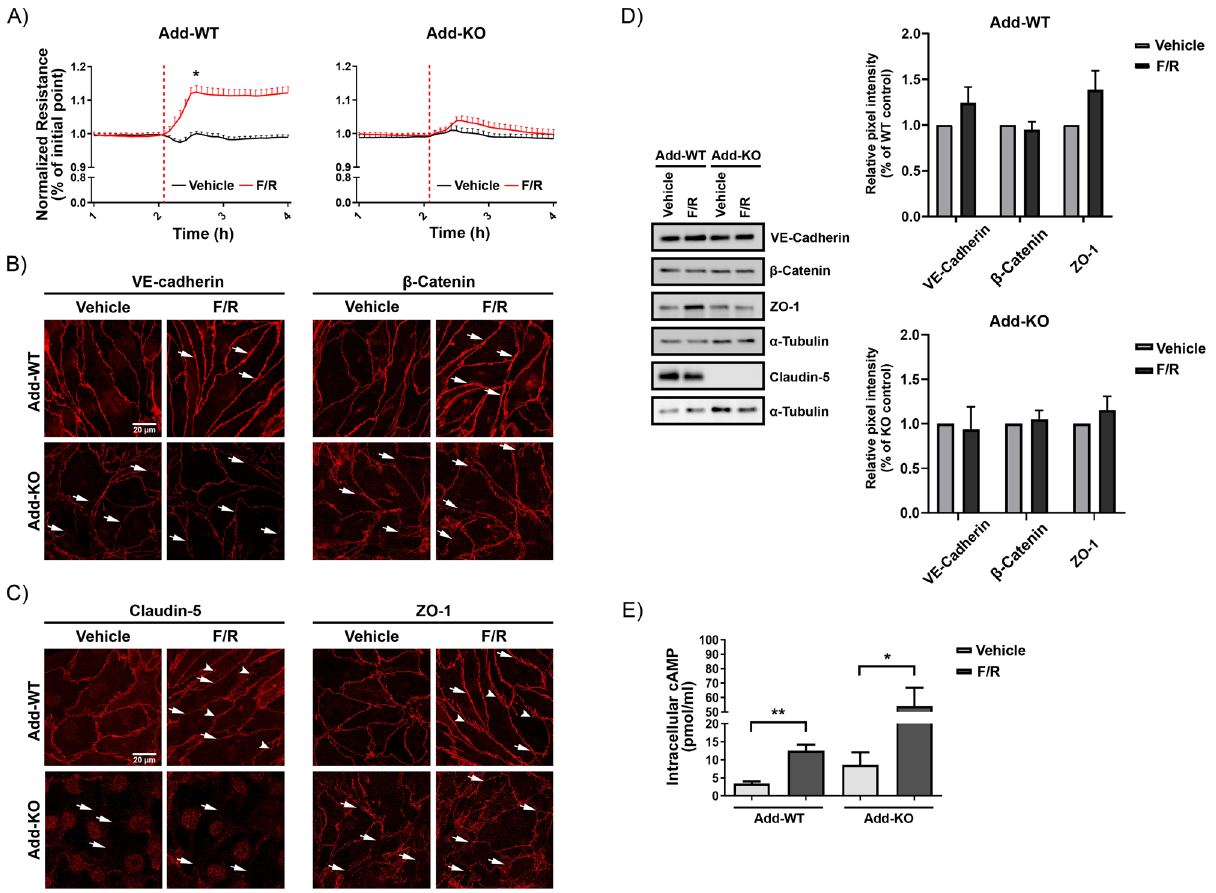
Figure 5. Effect of Adducin on cAMP-mediated endothelial barrier response. ( A ) Confluent WT and Add-KO cell monolayers were treated with Vehicle or F/R. The TER was measured up to 3 h after the treatment. The red-dashed line indicates the time of application. Data are normalized to the initial point of each corresponding group. “*” denotes significant difference between Vehicle and F/R in WT cells (N = 3 per group). Immunostainings for ( B ) VE-cadherin, β-catenin and ( C ) claudin-5, ZO-1 in WT and Add-KO cells treated for 1 h with either Vehicle or F/R. In WT cells arrows notice areas on the membrane where thicker signal is observed, arrowheads highlight finger-like projections. In KO cells arrows indicate fragmented junctional staining (N = 3–4 per group). ( D ) Representative Western blots for key AJ and TJ components from confluent WT and Add-KO cell monolayers exposed to Vehicle or F/R for 1 h. The graphs represent the relative pixel intensity of the bands, normalized to the WT, vehicle controls (N = 4 per group). ( E ) The graph shows intracellular cAMP concentration in pmol/ml from confluent endothelial cells monolayers analyzed by cAMP- specific ELISA (N = 8 per group). Data are represented as mean ± SEM; * p < 0.05; ** p <